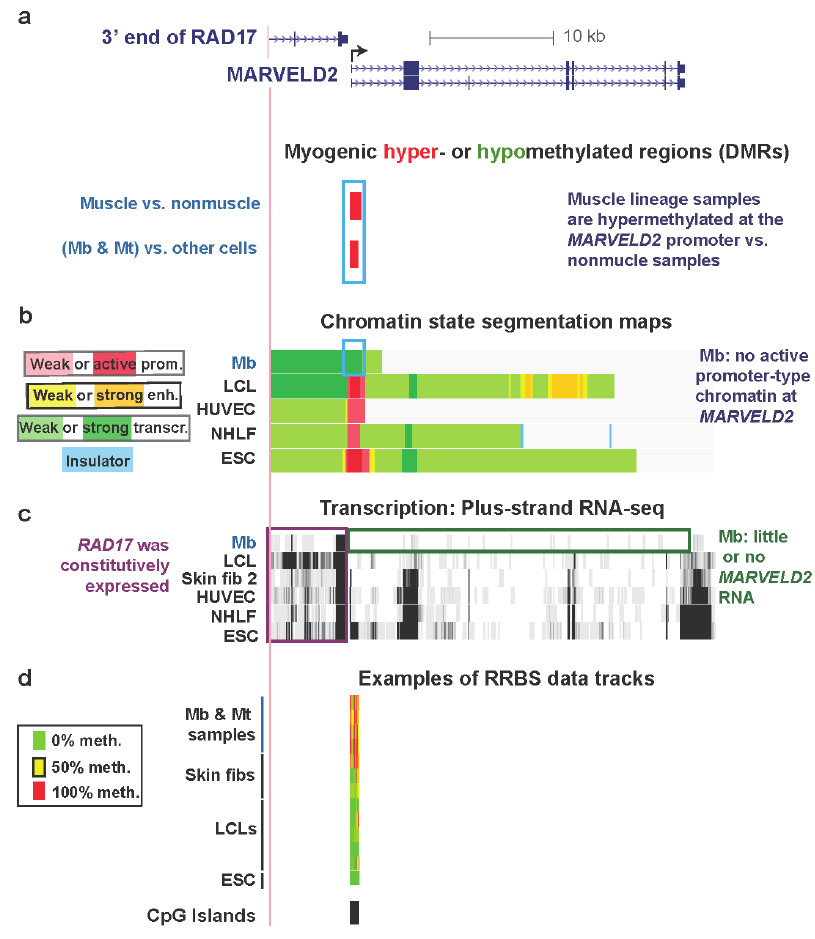
Figure 2. Myogenic hypermethylation at the silenced promoter of MARVELD2 without repressive chromatin marks. ( a ) RefSeq genes in this region (chr5:68704307-68740247, hg19) are shown. Only one of nine RAD17 isoforms is illustrated because all isoforms are the same in the 3' region that is depicted. Significantly hypermethylated (red) or hypomethylated (green, none seen) DMRs for the set of (Mb + Mt) samples vs . 16 types of nonmuscle cell cultures and for skeletal muscle vs . 14 types of nonmuscle tissue are aligned under the RefSeq genes. ( b ) The predicted chromatin structure (enh, enhancer; prom, promoter; transcr, transcriptionally active-type) based mostly on histone modifications [28]. ( c ) RNA-seq data for the plus-strand (vertical viewing range, 1-to-10). In this region, no specific signal was seen for the minus-strand. ( d ) Examples of RRBS data and the positions of CGIs. Using an 11-color, semi-continuous scale (see color guide), the RRBS tracks indicate the average DNA methylation levels at each monitored CpG site from the quantitative sequencing data [9,18]. The RRBS data are shown for four independent Mb cultures and Mt preparations from them; one female skin and two foreskin fibroblast cultures; five independent lymphoblastoid cell lines (LCLs), and H1 embryonic stem cells (ESC). The blue, purple, and green boxes indicate noteworthy features. In this and subsequent figures, all tracks are aligned, are from the UCSC Genome Browser [29], and are ENCODE data except for the differential methylation tracks and the MyoD binding tracks in subsequent figures, which are custom